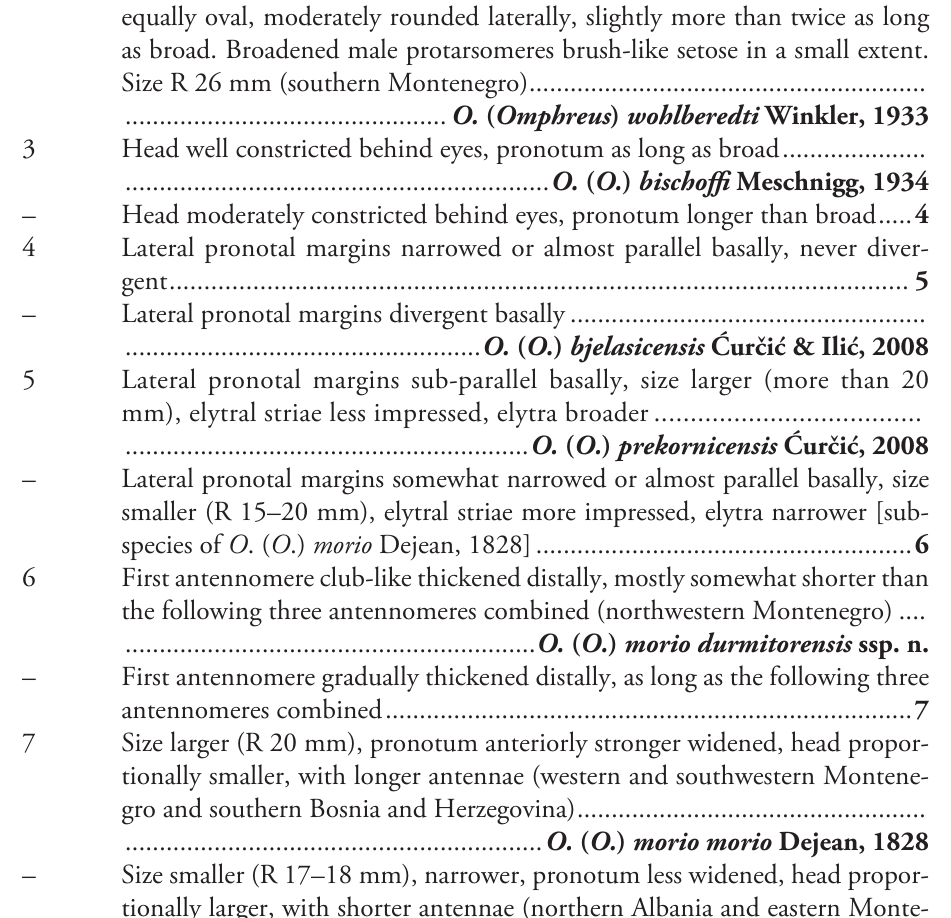
Size smaller (R 17–18 mm), narrower, pronotum less widened, head propor- tionally larger, with shorter antennae (northern Albania and eastern Monte-